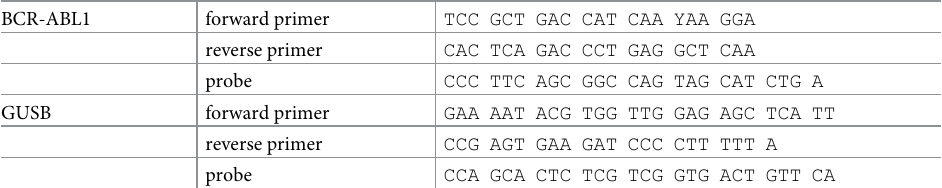
Table 1. List of primers and